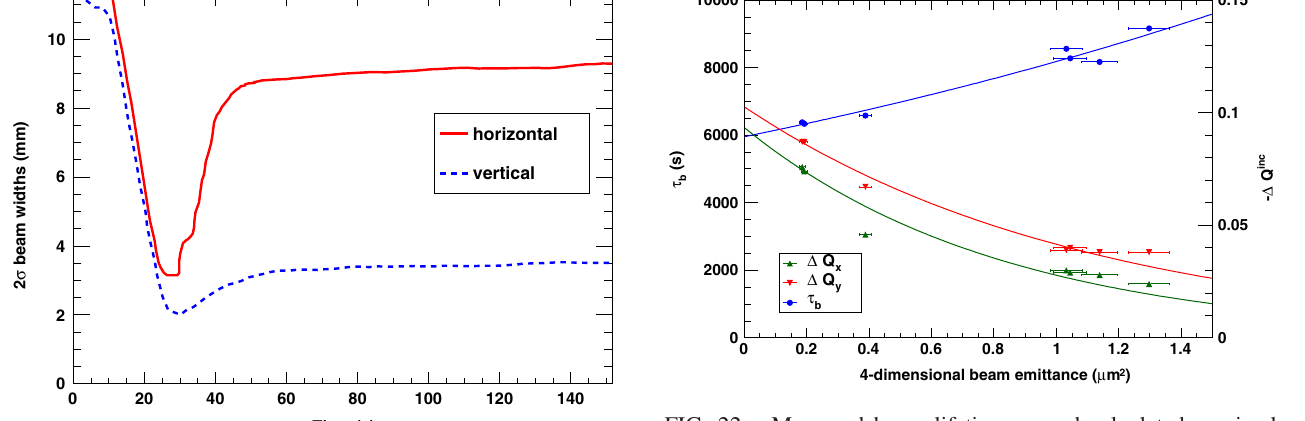
FIG. 22. Measured beam lifetime τ and calculated maximal b incoherent tune shift − Δ Q inc from (35) as a function of the four- x;y dimensional beam emittance [see (34)]. The beam lifetime (blue dots) increases from 6300 to 9200 s with increasing beam emittance. The lines are shown to guide the